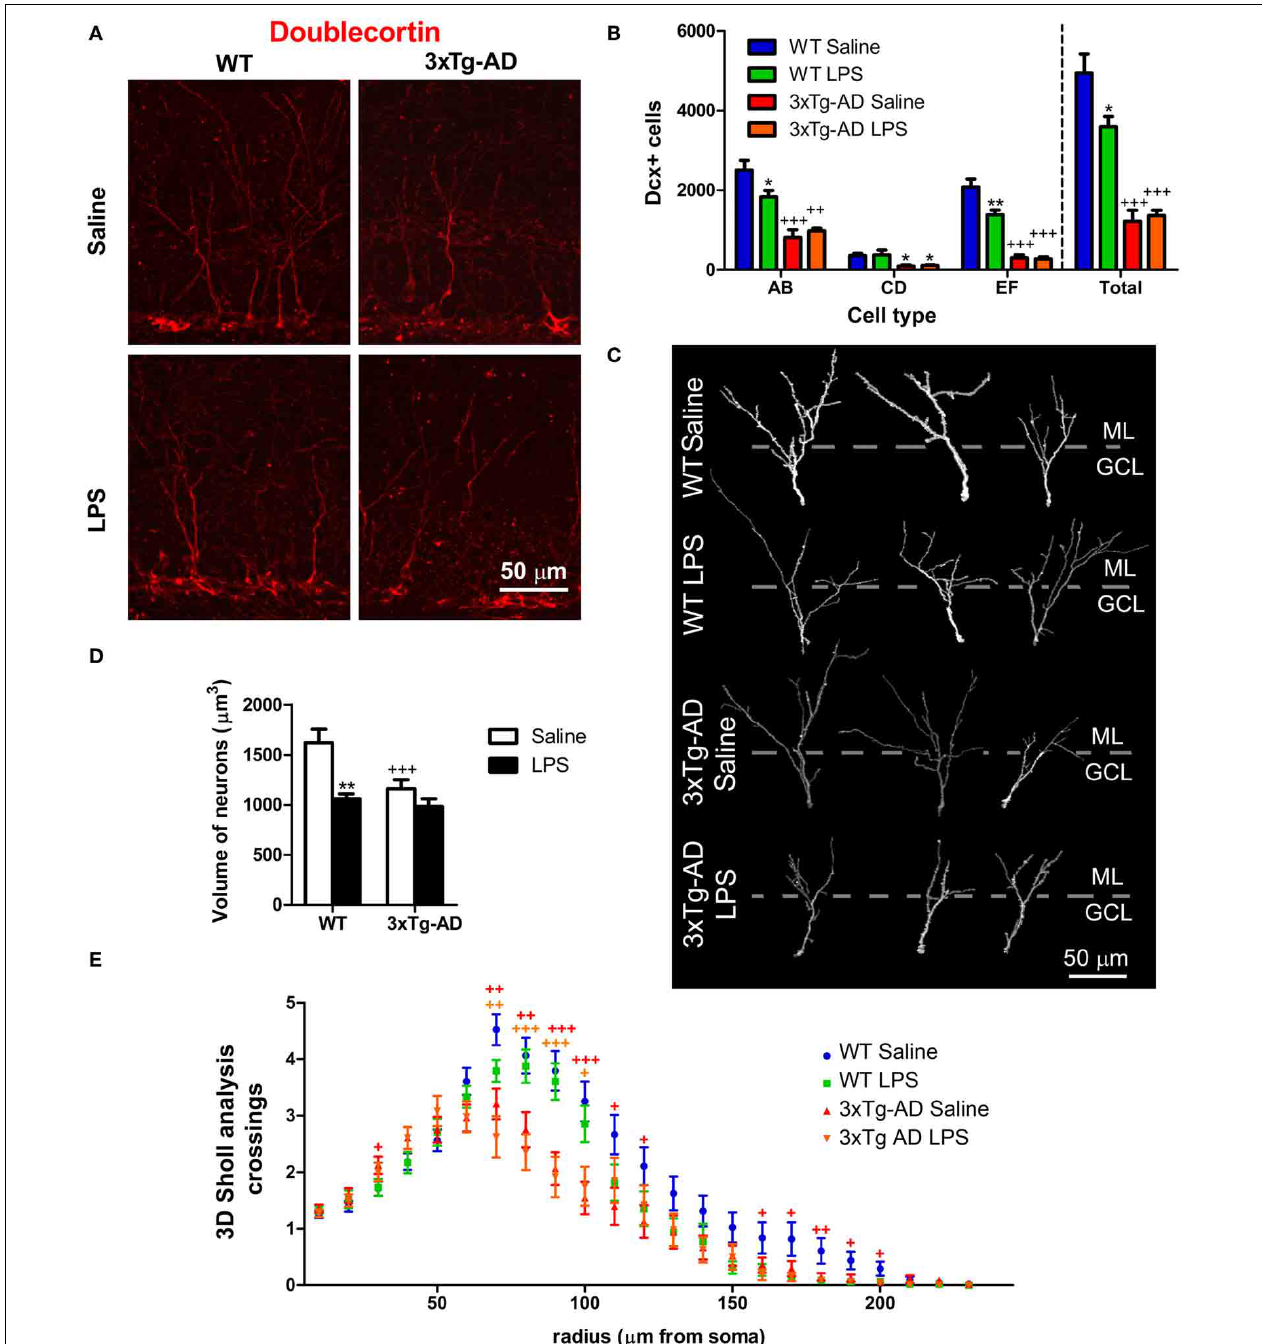
FIGURE 4 | LPS effect on number and morphology of doublecortin-positive cells. (A) Representative confocal microscopy images showing Dcx-positive cells in the dentate gyrus (DG). (B) Quantitative analysis reveals a significant reduction in the number of Dcx-labeled cells in the DG of 3xTg-AD mice compared with WT mice. The number of AB and EF-type cells, but not CD-type, was significantly decreased in WT mice ∼ 7 weeks after LPS treatment. (C) Three dimensional reconstructions of representative doublecortin (Dcx) stained